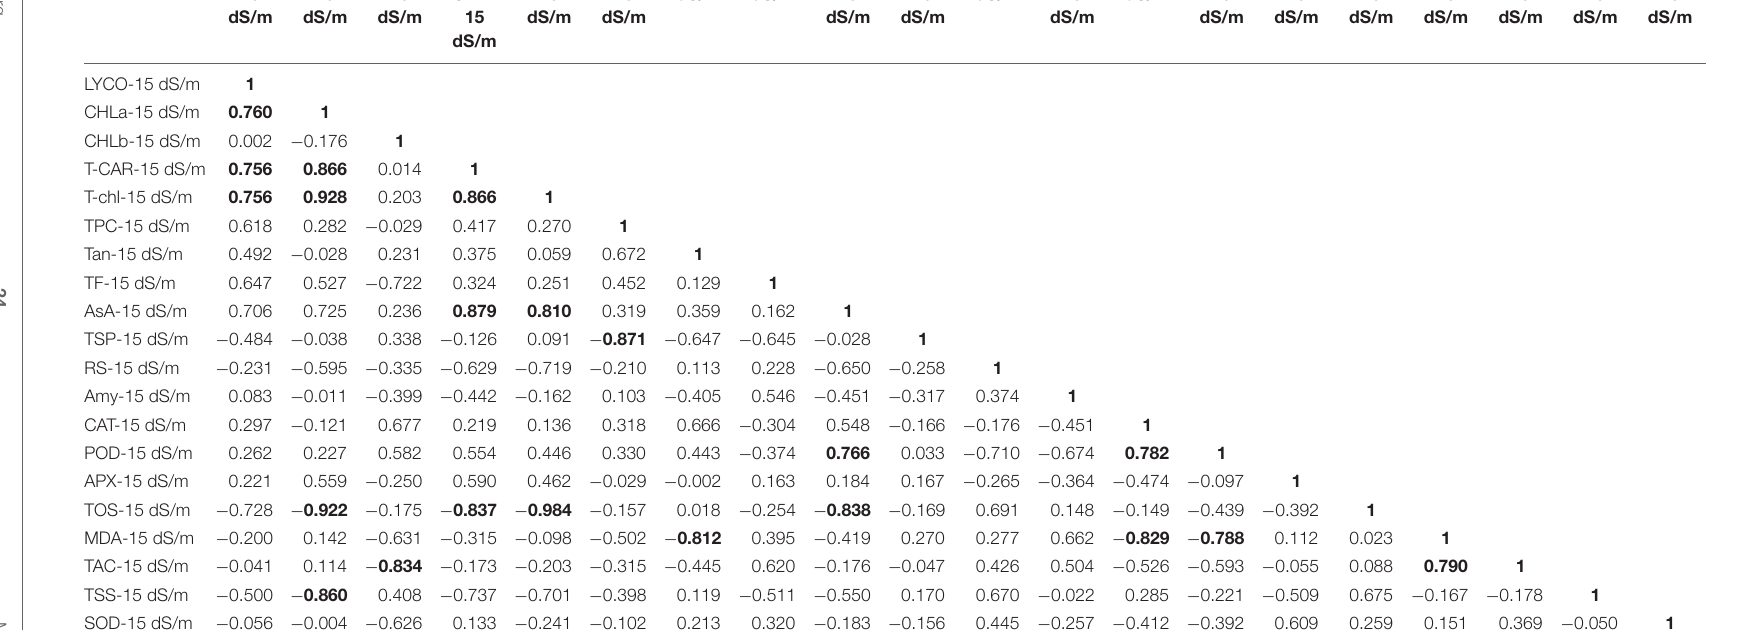
TABLE 16 | Correlation matrix for biochemical traits under 15 dS/m salt stress condition. Variables